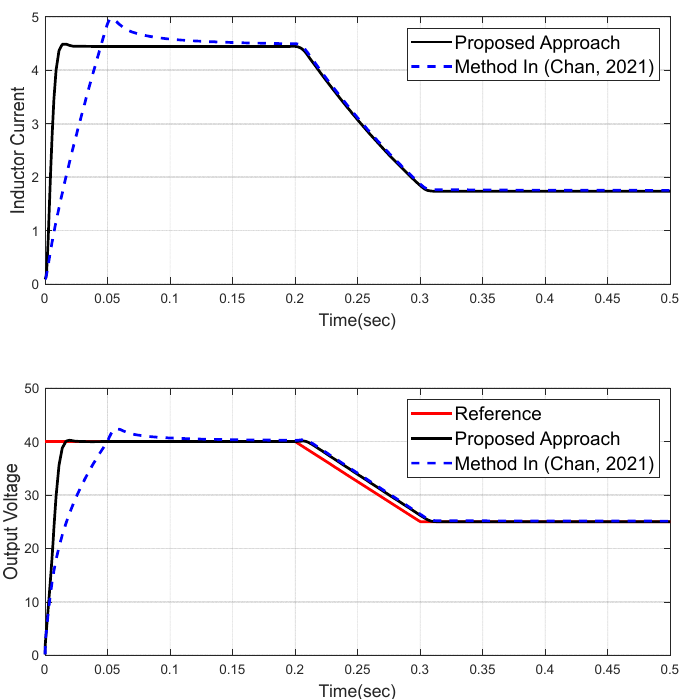
Figure 15. Comparison of the behaviour of the inductor current and output voltage with the results of the method in Ref. [1] in case of output voltage changes.